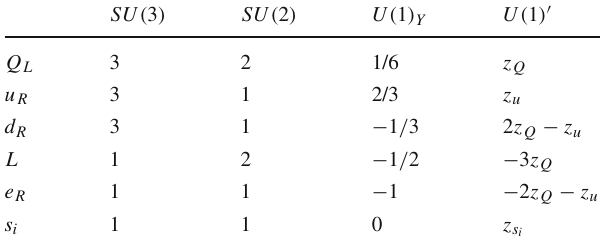
Table 3 Flavour universal charge assignment in the U ( 1 ) (cid:4) extension of the